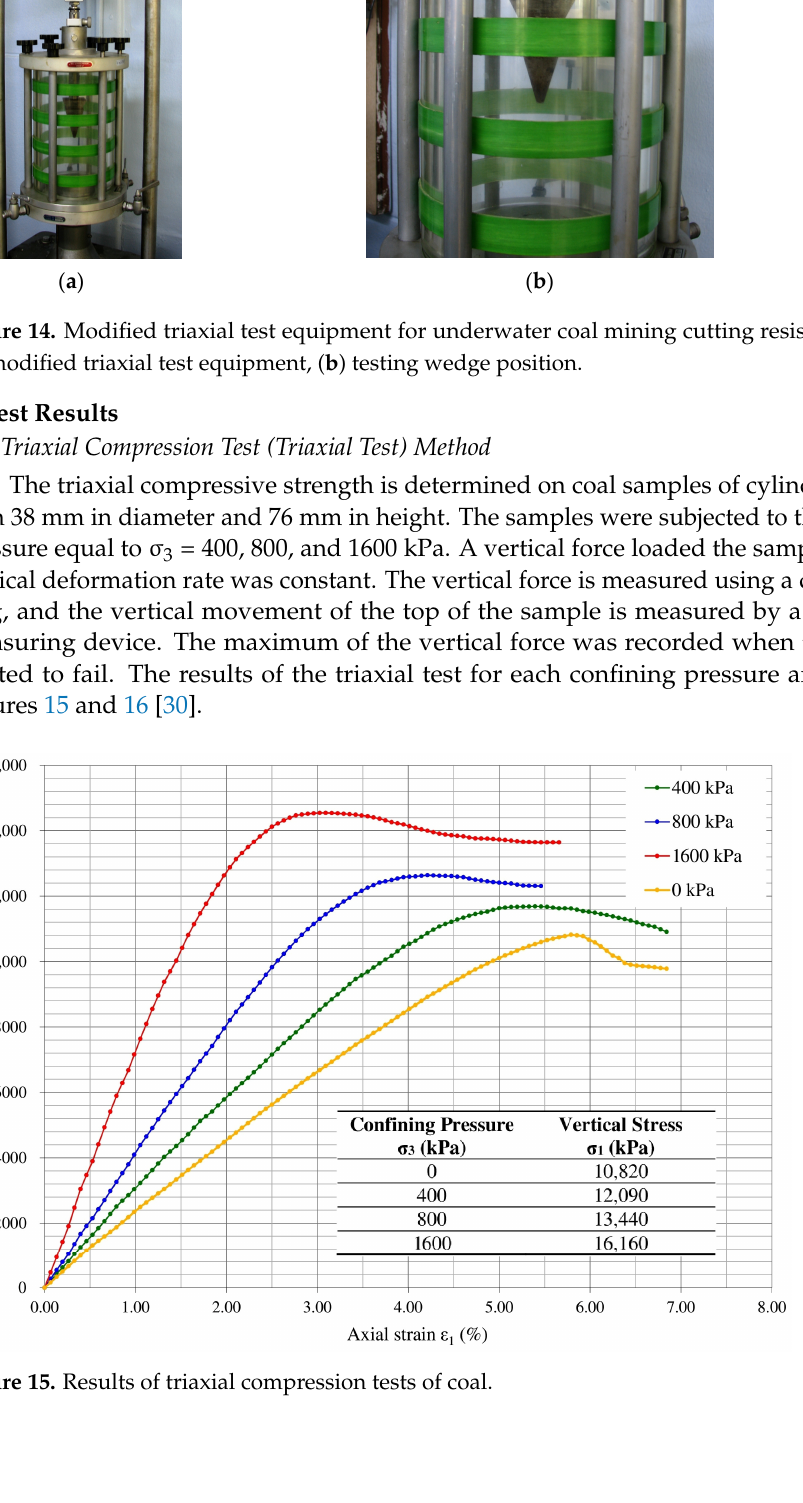
Figure 16. Shear strength of coal.